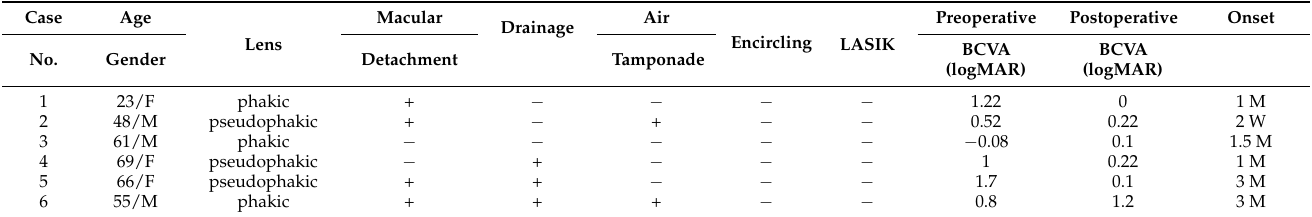
Table 3. Patients with CME after scleral buckling